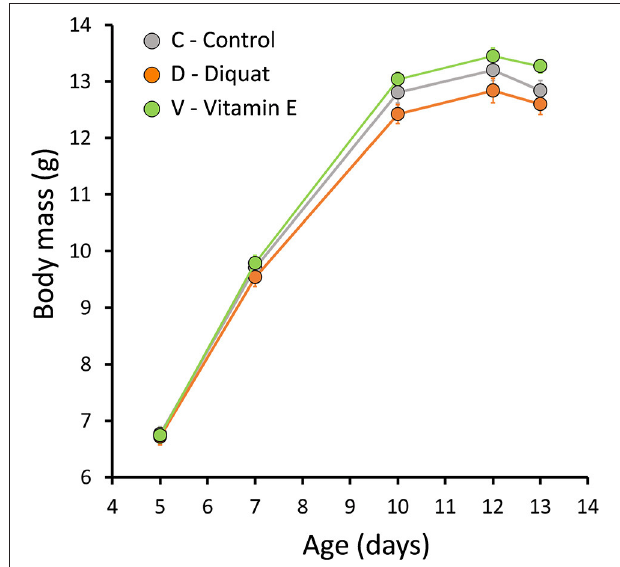
FIGURE 1 | Effect of the experimental treatments (diquat injections, vitamin E supplementation or control) on body mass (mean ± s.e.).